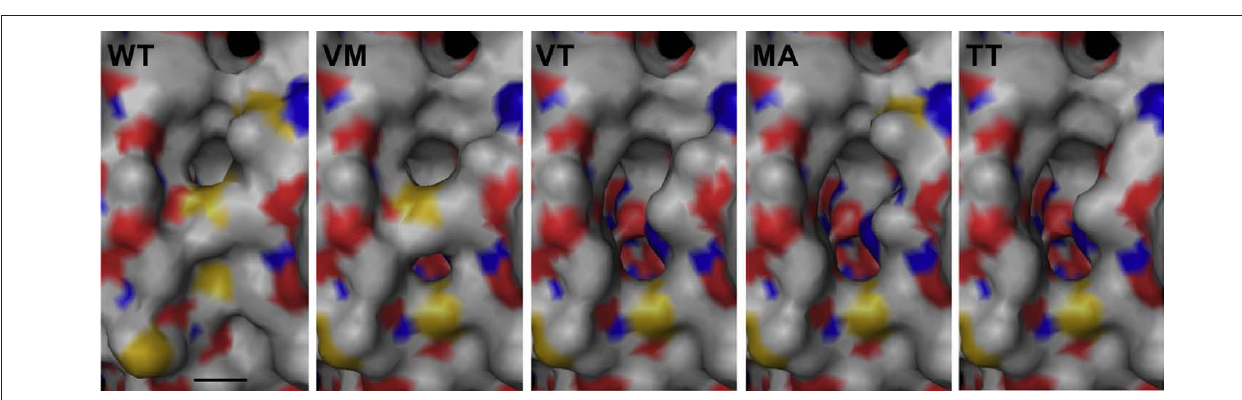
FiguRe 5 | Modeling of active site pore mutants based on the wild type (WT) structure at the SwissModel server (Arnold et al., 2006). Abbreviations and symbols: VM, M V; VT, MM VT; MA, M A; TT, MM TT; bar, 4 Å. 296 296/297 297 296/297